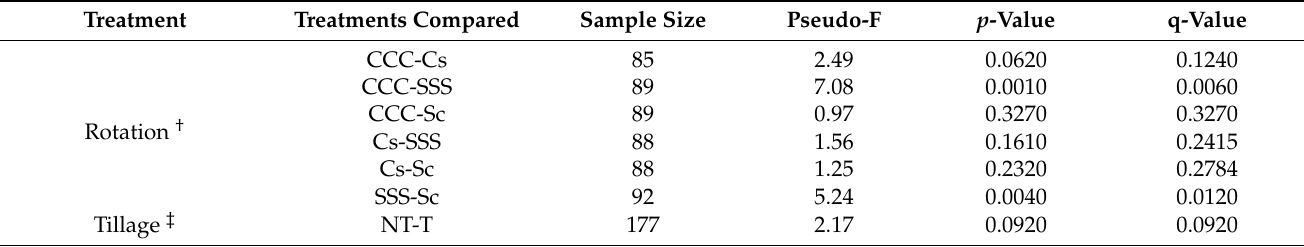
Table 4. Community structure ( β -diversity) measures for archaea following 20 years of crop rotation and tillage treatments, and their interaction, based on pairwise permanova computation of weighted unifrac distances. The pseudo-F column represents the comparison between UniFrac distances for a given treatment combination (listed in the Treatments Compared column). The p -value and q-value columns indicate the probability of type I and type II errors associated with the treatment comparisons,